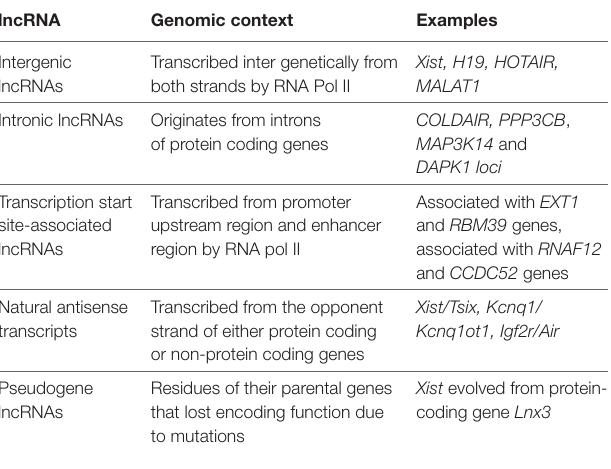
TABLe 1 | Classification of long non-coding RNAs (lncRNAs) based on genomic